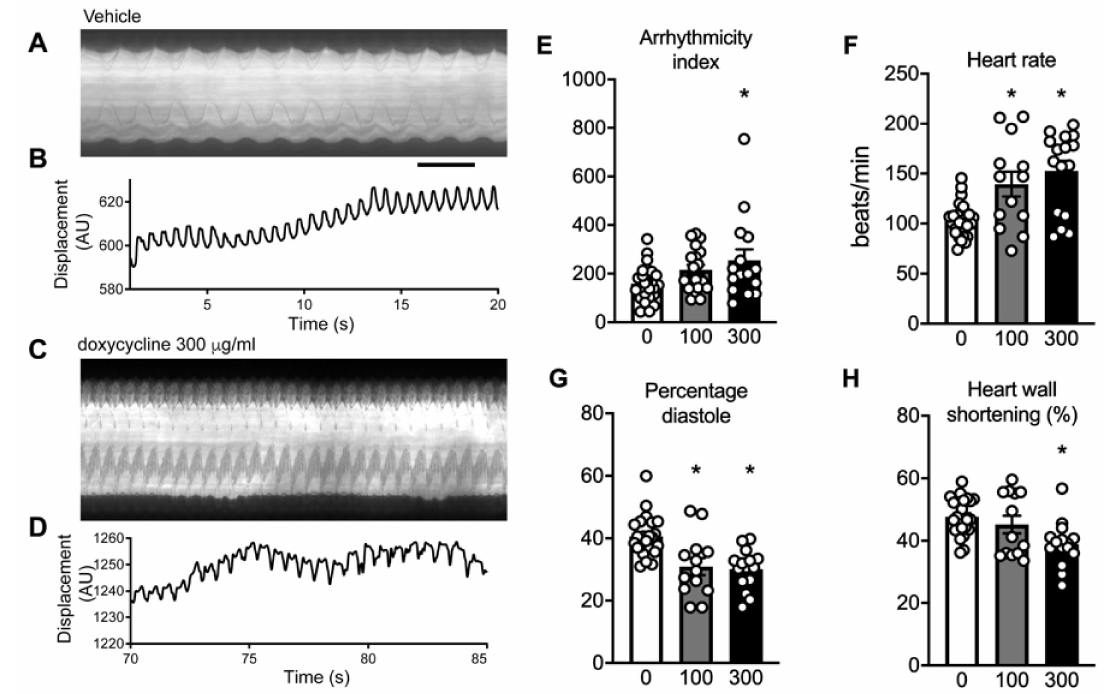
Figure 5. Arrhythmias and contractile dysfunction in the heart of Drosophila melanogaster exposed to doxycycline. ( A – D ) Typical examples of kymographs and cardiac wall displacements obtained from videos of the cardiac wall in prepupae of Drosophila melanogaster . ( E ) Exposure to high-dose doxycycline (300 µ g/mL) resulted in a significantly higher arrhyth- micity index, indicative of a higher occurrence of arrhythmias compared to vehicle or low concentration of doxycycline (100 µ g/mL). ( F ) Basal heart rate was significantly higher at 300 µ g/mL doxycycline, with intermediate values at 100 µ g/mL. ( G ) The relative time of diastole was shortened, indicative of diastolic dysfunction, after both concentrations of doxycycline. ( H ) Contractile dysfunction was observed as the heart wall shortening was reduced after doxycycline treatment. Bar graphs are mean ± SEM. *: P < 0.05, one-way ANOVA followed by Tukey’s post-hoc test for multiple